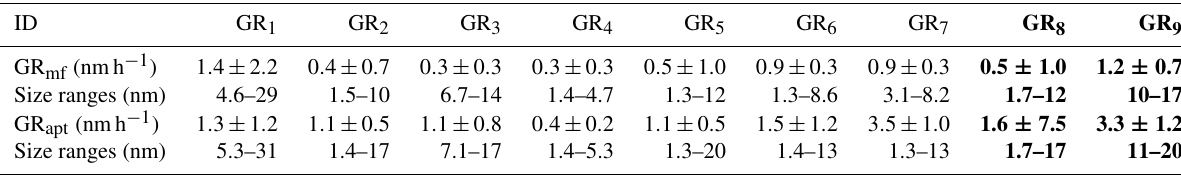
Figure 7. A cloud activation event observed on 20 January 2011. (a) DMPS spectra; (b) AIS positive polarity spectra; (c) ion and particle concentrations in four different size ranges: ions of diameters below 1.9nm, ions of diameters between 1.9 and 10nm, total particles of diameters between 10 and 100nm, and total particles of diameters above 100nm; (d) ambient air temperature ( T ); (e) wind direction, colour- coded with wind speed; and (f) activation diameter ( D 50 ), determined based on the method described by Komppula et al. (2005). Data are presented in UTC. Table 1. GRs estimated from linear fittings with root-mean-square errors expressed as uncertainties for the nine growth modes shown in Fig. 5. GR mf stands for GRs determined by the mode-fitting method and GR apt for those determined by the appearance time method. Normal text in the table corresponds to GRs determined from the AIS measurement (9–12 March 2011) and bold text to GRs determined from the DMPS measurement (25 February,